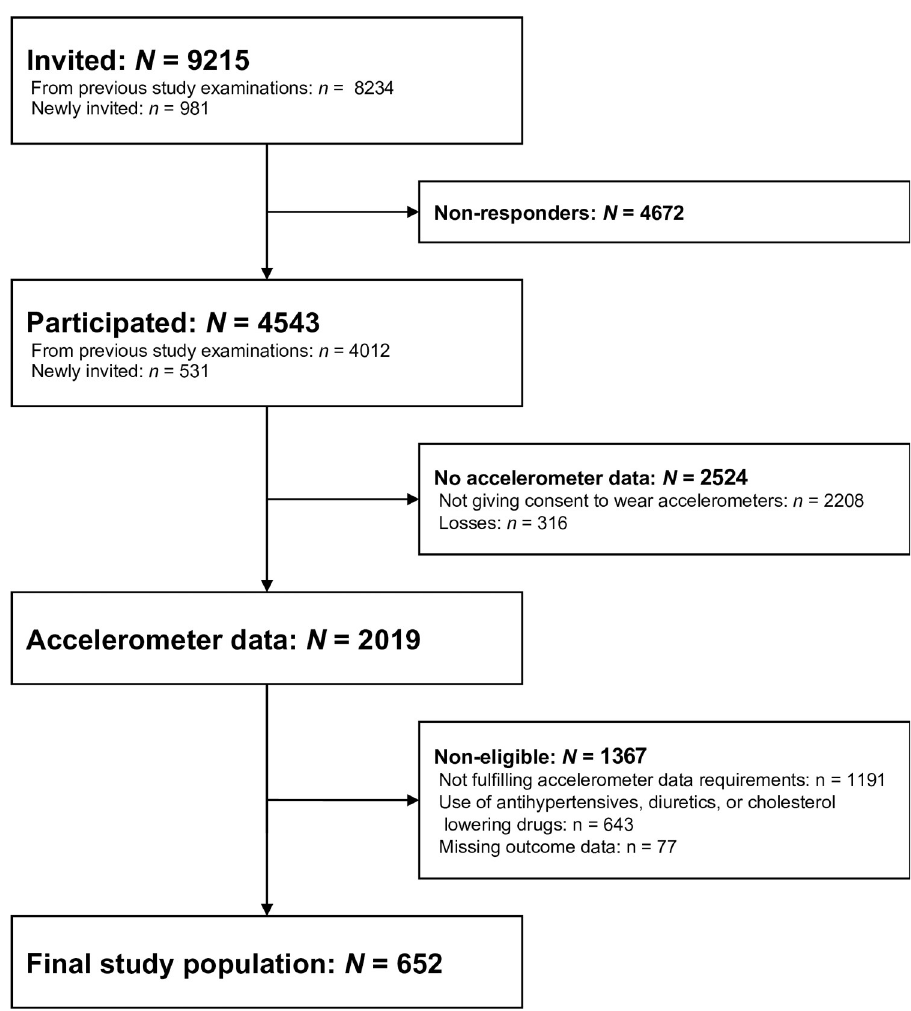
Fig 1. Formation of the final study population of eligible participants in the fifth examination of the Copenhagen City Heart Study. N / n indicates number of participants. The sum across reasons for exclusion of non-eligible study participants exceeds 1367 since some participants fulfilled more than one exclusion